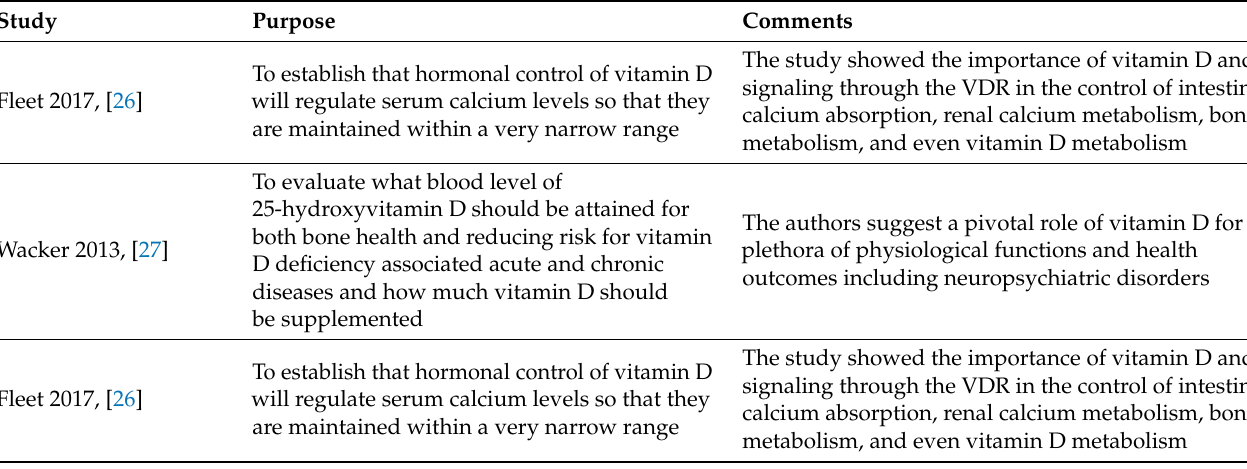
Table 1. The risk of vitamin D